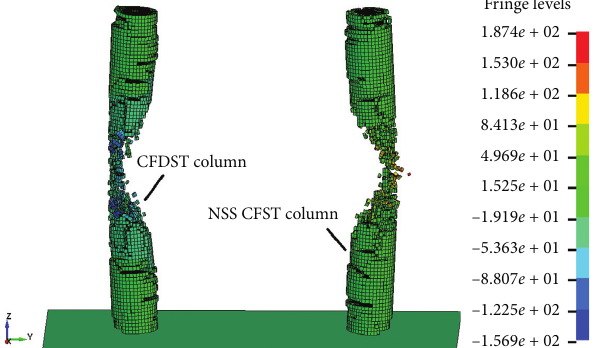
Figure 17: Damage of inner concrete of two different column types.